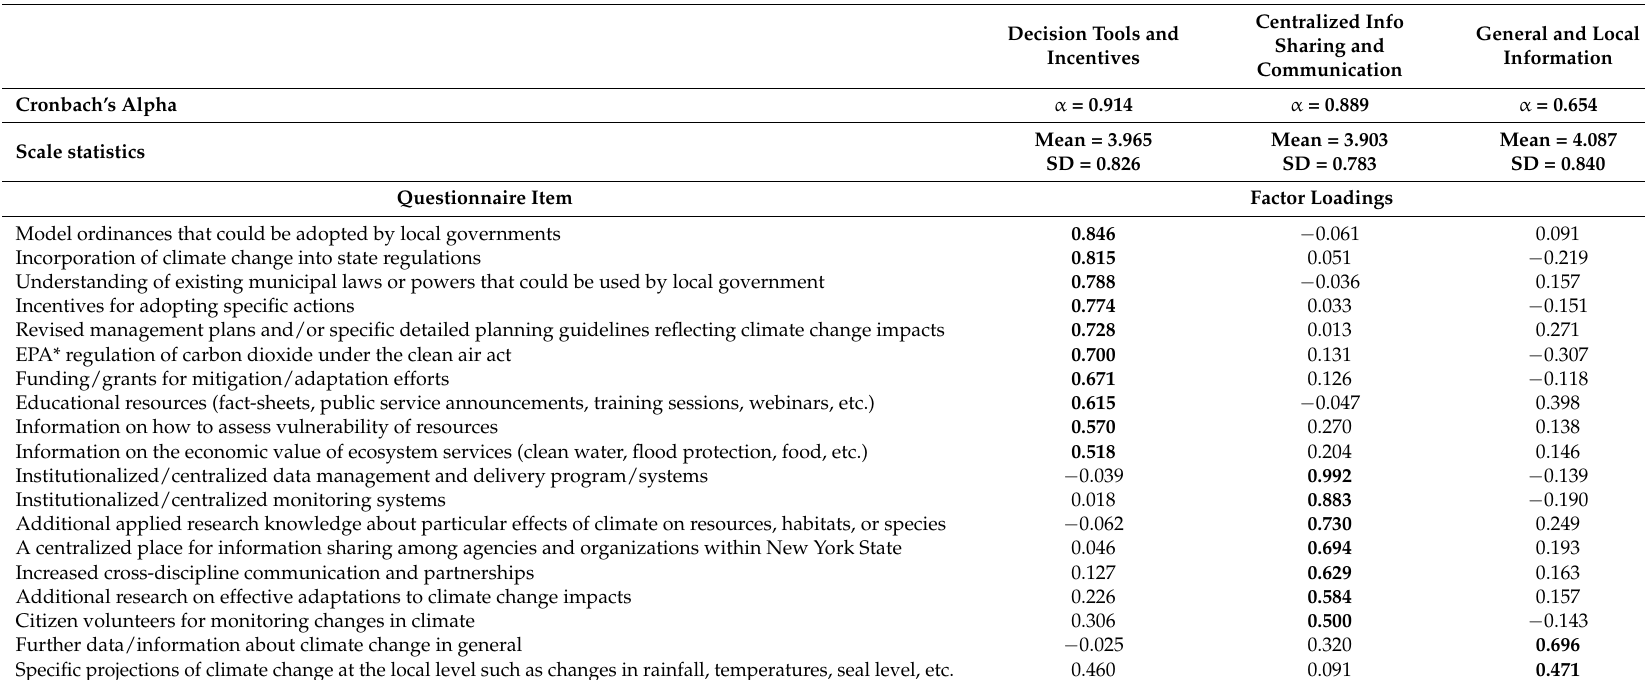
Table 3. Factor analysis results for “Resources Needed” 1 including factor loadings, Cronbach’s alpha, and scale mean and standard